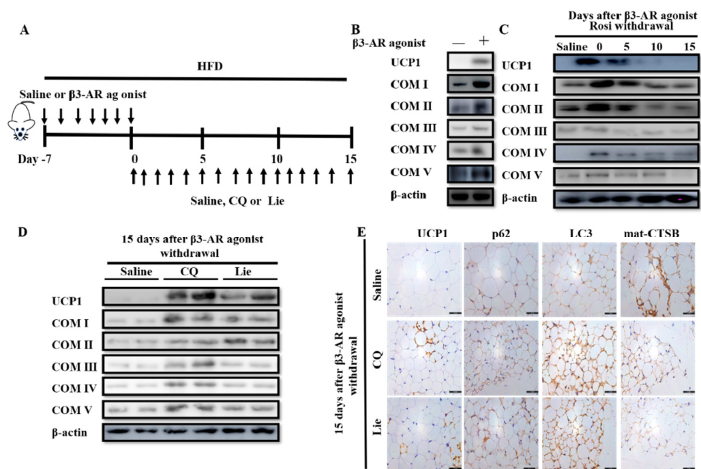
Figure 4. Lie retained the molecular characteristics of beige adipocytes after β 3-AR agonist withdrawal in vivo. ( A ) Schematic illustration about in vivo experiments. Mice were treated with the HFD + β 3-AR agonist or high fat diet (HFD + ) saline for 7 days consecutively and after β 3-AR agonist withdrawal, the mice were treated with HFD + 60 mg · kg − 1 CQ, HFD + 60 mg · kg − 1 Lie or HFD + saline